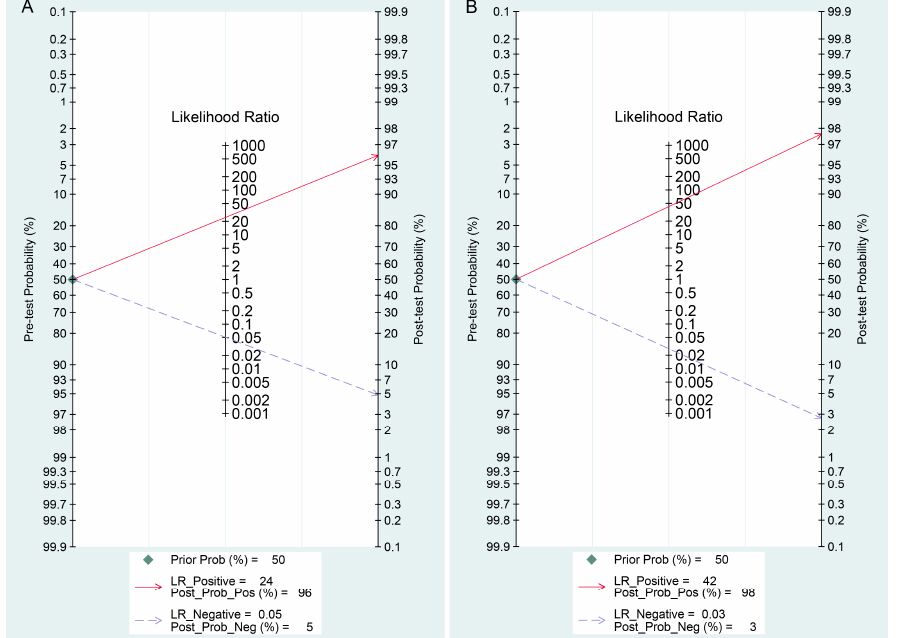
Figure 6. Fagan’s nomogram assessing the clinical diagnostic value of ( A ) ICA- and ( B ) NAIA-based POCTs for PEDV testing.